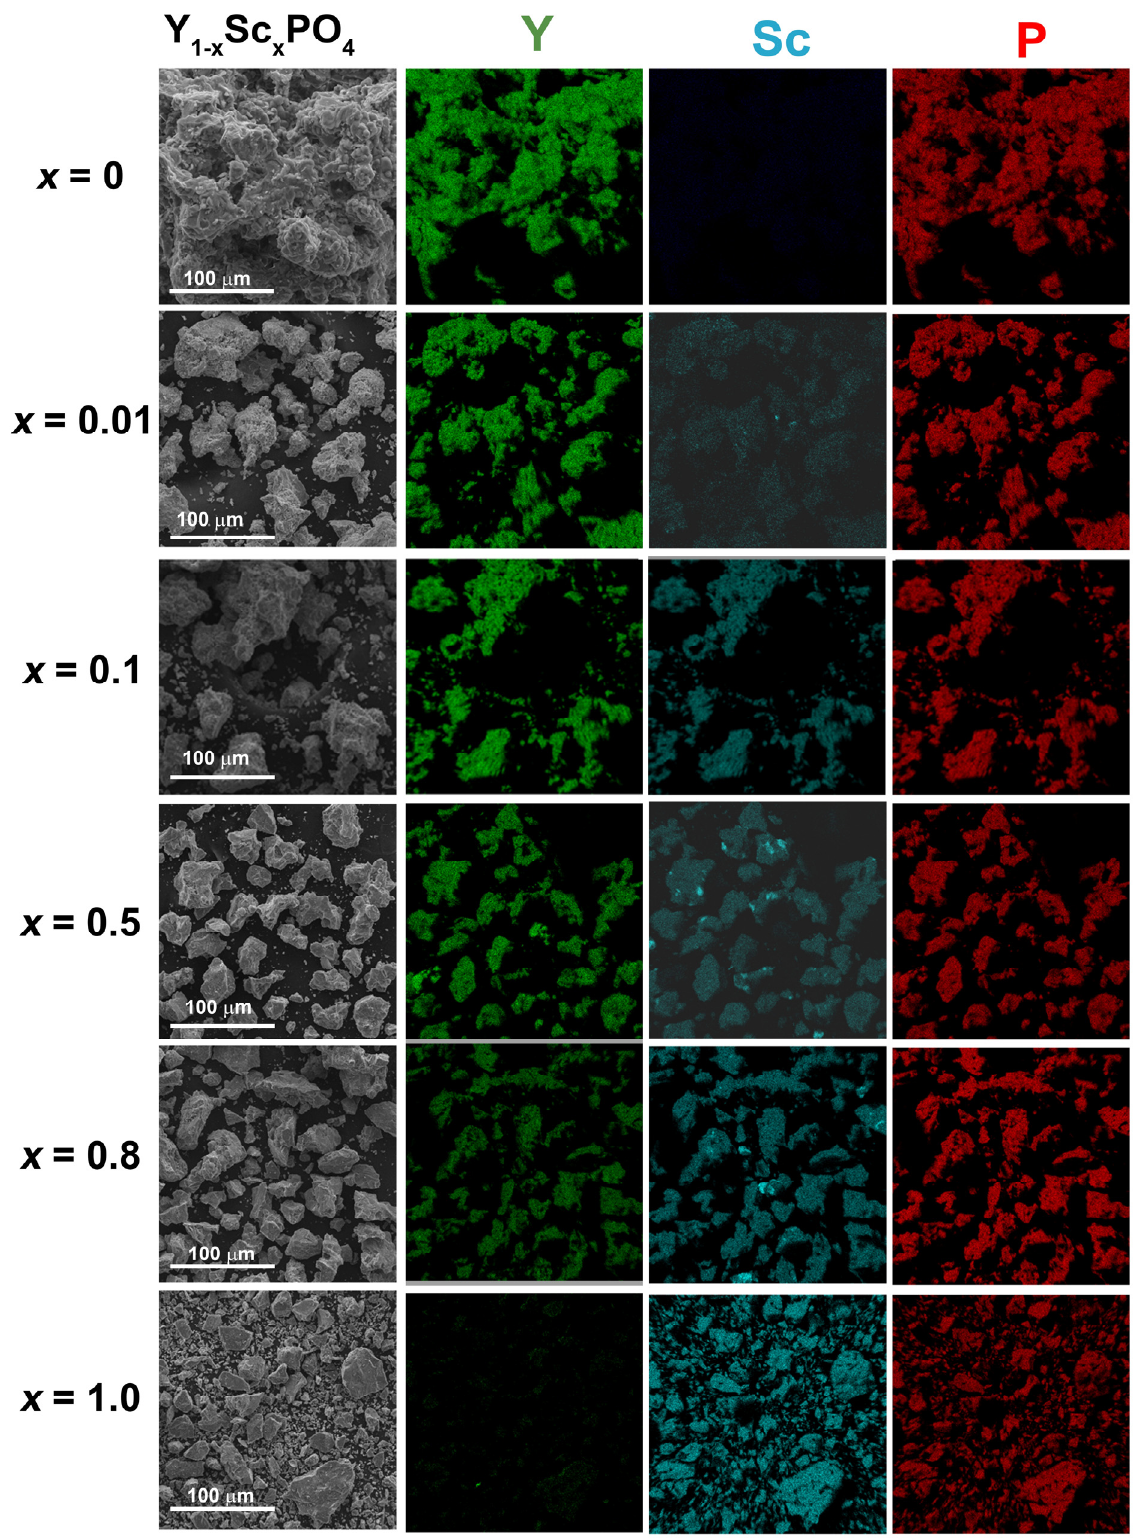
Figure 2. SEM images (left column) and elemental mapping of Y, Sc and P for Y 1 − x Sc x PO 4 ( x = 0, 0.01, 0.1 0.5, 0.8, 1.0).